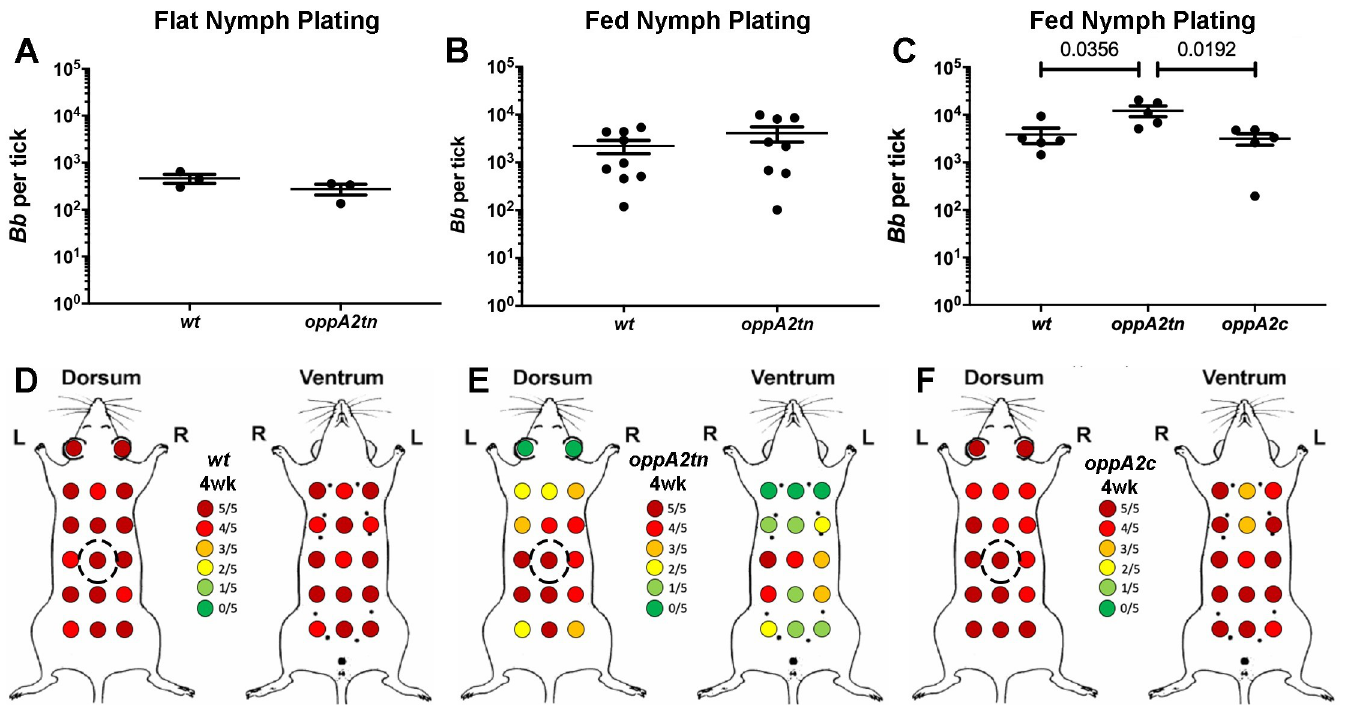
Fig 6. oppA2 is dispensible for survival in the tick midgut and transmission. (A-B) Colony counts (mean ± SEM) from midguts of (A) flat and (B) fed nymphs infected with wt or oppA2tn . (C) Colony counts (mean ± SEM) from midguts of fed nymphs infected with wt , oppA2tn , or oppA2c . Each data point represents a separate pool of ticks. Statistical analysis of tick studies was determined by unpaired Student’s t test. (D-F) Maps of skin sample sites and culture results for mice dorsally-infected via nymph feeding with wt (A), oppA2tn (B), or oppA2c (C) (n = 5). Dotted circles denote capsule placement for nymphal feeding.